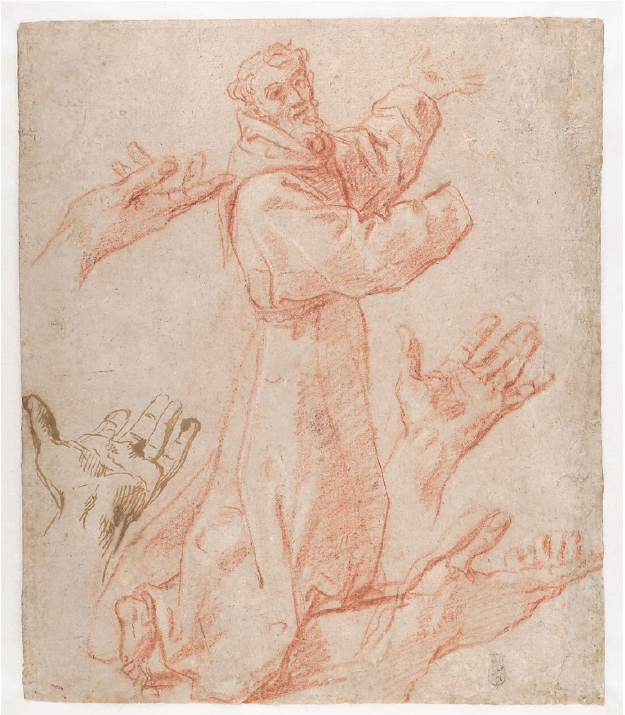
Figure 2. Annibale Carracci, St. Francis (Study for the Pietà with Saints) , 1583–1585. Drawing. Image Courtesy of Metropolitan Museum of Art, New York, U.S. Rogers Fund, 1972; https://www.metmuseum.org/ (accessed on 20 June 2021).